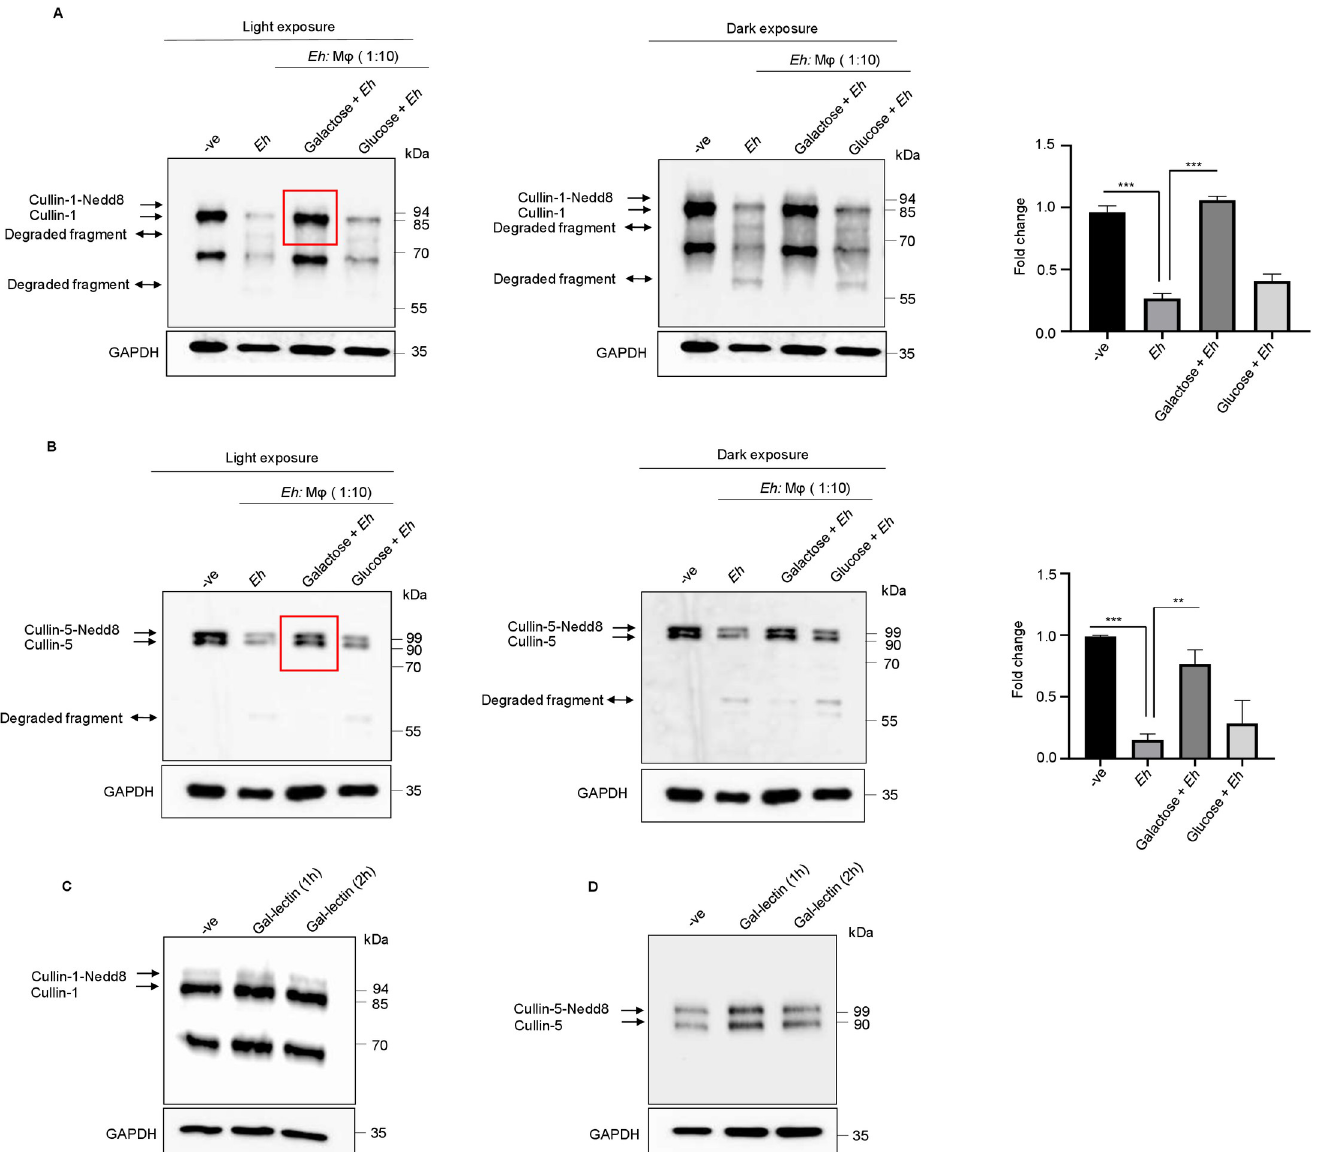
Fig 2. Cullin-1/5 degradation requires Gal-lectin-mediated contact with macrophage. (A, B) THP-1 macrophages were stimulated with either Eh (10:1 ratio) alone or with Eh preincubated with 55mM Galactose or Glucose for 10 min at room temperature and the degradation of the cullin-1/5 determined. (C, D) THP-1 macrophages were stimulated with native Eh Gal-lectin (500ng/ml) for 1h and 2h. Post incubation, cells were washed and lysed. Equal amount of protein was loaded onto 7.5% SDS-PAGE gel and immunoblotted with anti-cullin-1, anti-cullin-5 and anti-GAPDH antibody. Highlighted boxed areas on the figures show point of interest for cullin-1/5 as described in text. Data are representative of three independent experiments and statistical significance was carried out with Students t- test. Bar represent mean ± SEM. �� P < 0.01, ��� P < 0.001. https://doi.org/10.1371/journal.ppat.1009936.g002 and caspase-4 formed a protein complex that enhanced the cleavage of caspase-1 CARD domains to augment IL-1 β release and cleavage of gasdermin D that regulated pro-inflamma- tory cytokine release [37]. Eh in contact with macrophages also activate caspase-6 that medi- ates cytoskeletal-associated protein degradation [25] and caspase-3 important for apoptosis [45]. To determine if inflammatory caspases played a role in cleaving cullin-1/5, we used the bioinformatic software Peptide Cutter (ExPASy) (https://web.expasy.org/peptide_cutter/) that